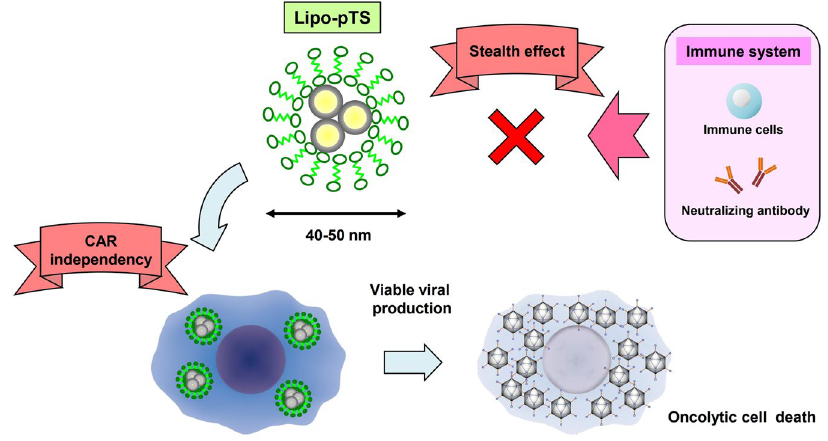
Figure 7. Schematic